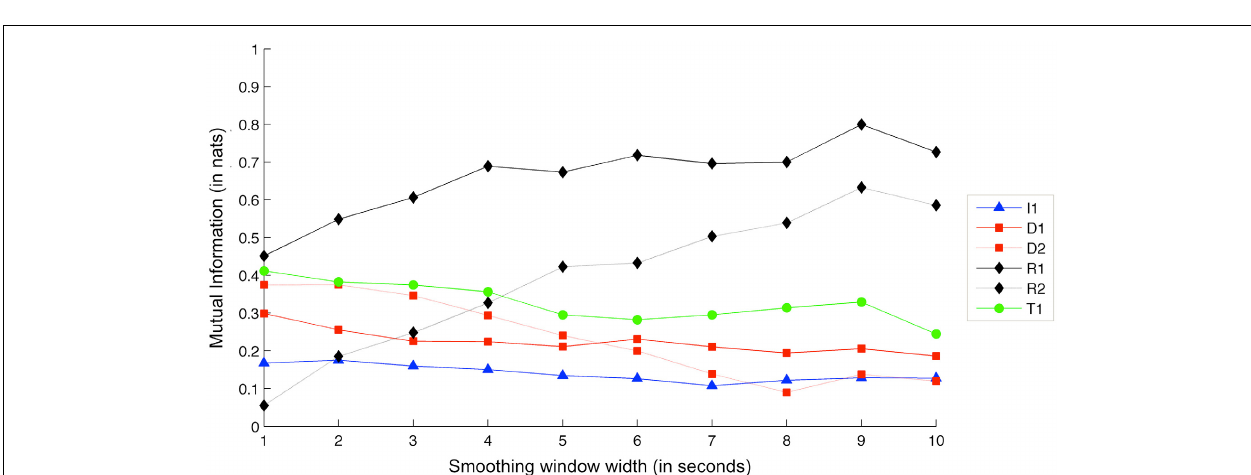
FIGURE 11 | Interdependence gain for the Timbre dimension, for different exercises and window sizes. (Legend: I1, Intonation exercise; D1, Dynamics exercise nr.1; D2, Dynamics exercise nr.2; R1, Rhythm exercise nr.1; R2, Rhythm exercise nr.2; T1, Timbre exercise).